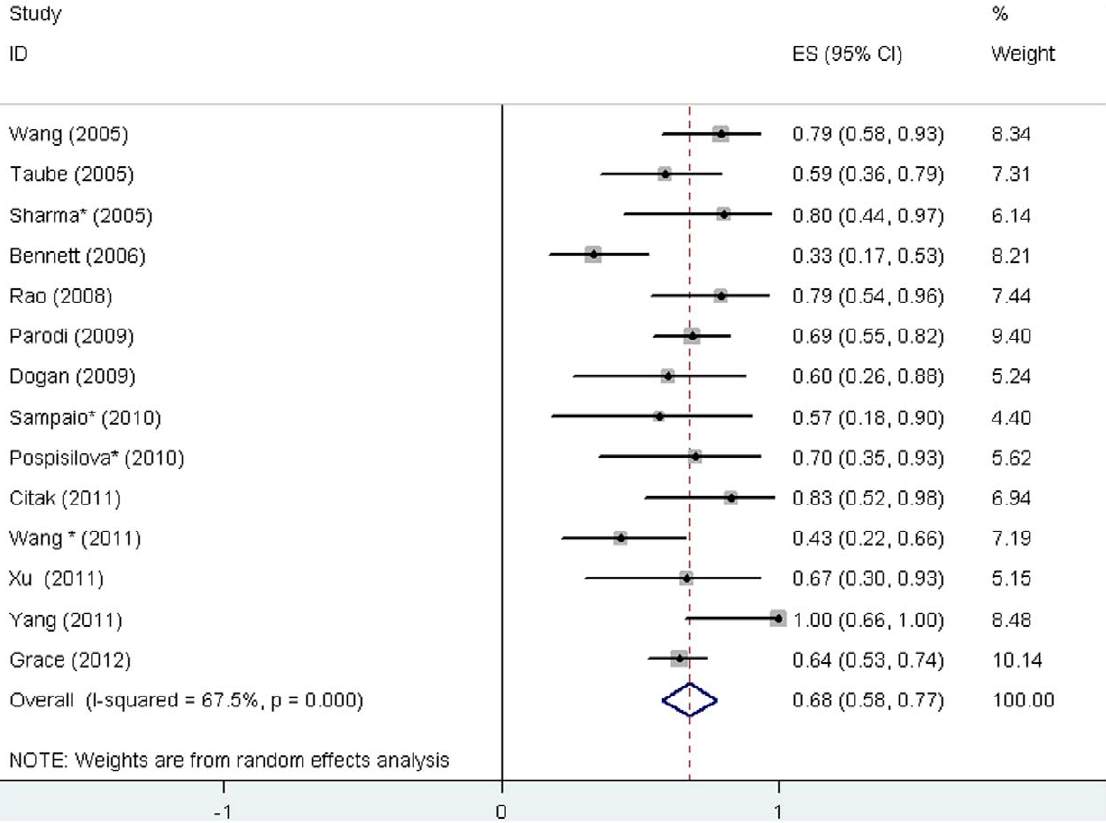
Figure 2. Response rate to rituximab in children with ITP. This forest plot is created by the software of STATA 11.1. Solid boxes indicate the response rate in each study. Horizontal lines indicated 95% CIs. The diamond indicates the pooled response rate (68%). Test of heterogeneity: I 2 =67.5%, P , 0.001.